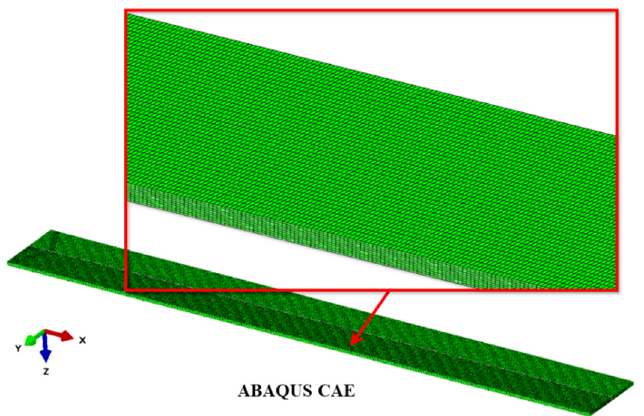
Figure 3. A finite element mesh used in simulations.